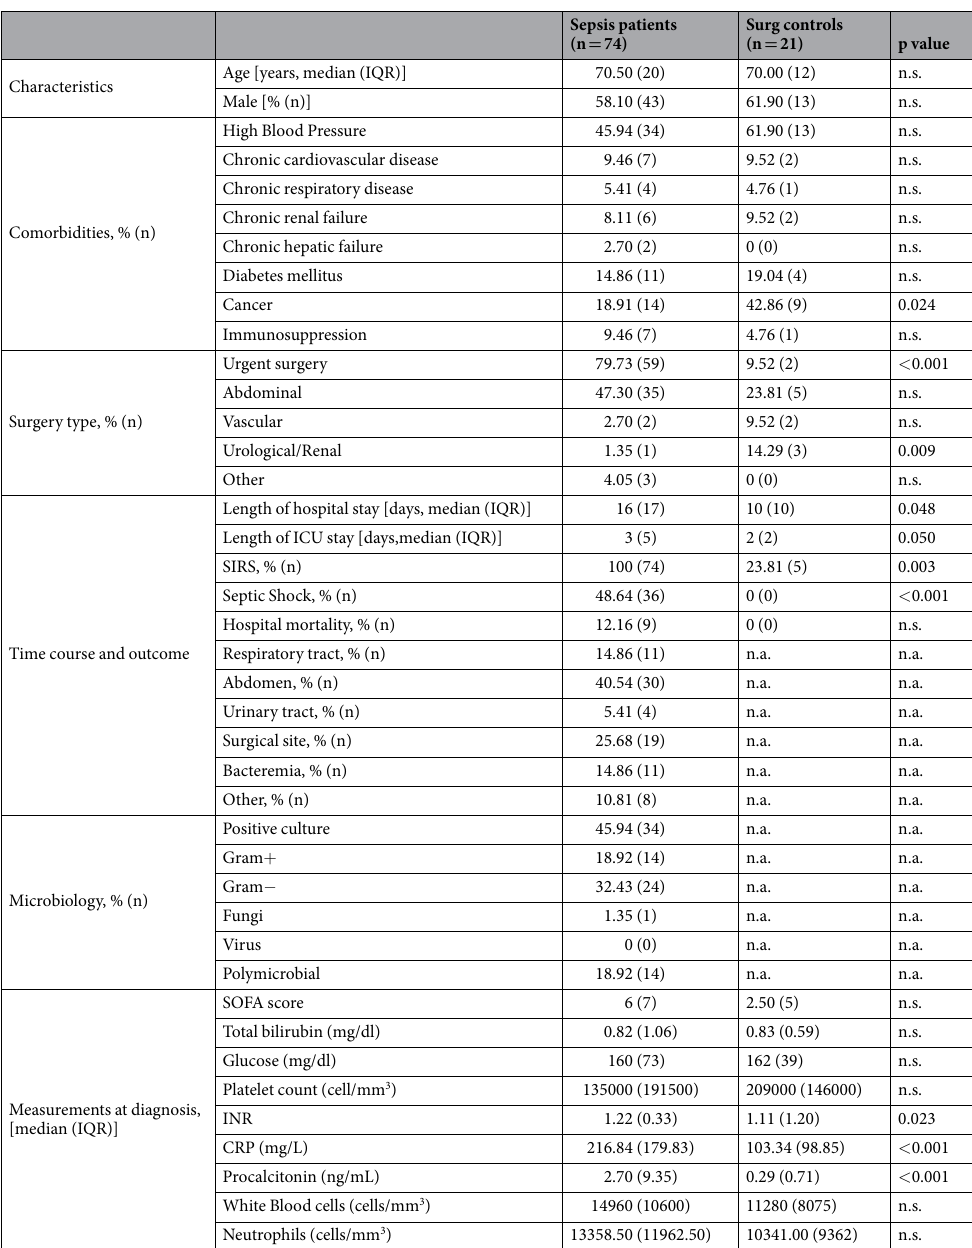
Table 2. Clinical characteristics of the patients in the validation cohort: continuous variables are represented as median, (interquartile range, IQR); categorical variables were represented as (%, n). ICU: intensive care unit; SIRS: systemic inflammatory response syndrome, SOFA: Sequential Organ Failure Score; CRP, C reactive protein; INR, international normalized ratio; n.s: not significant; n.a: not